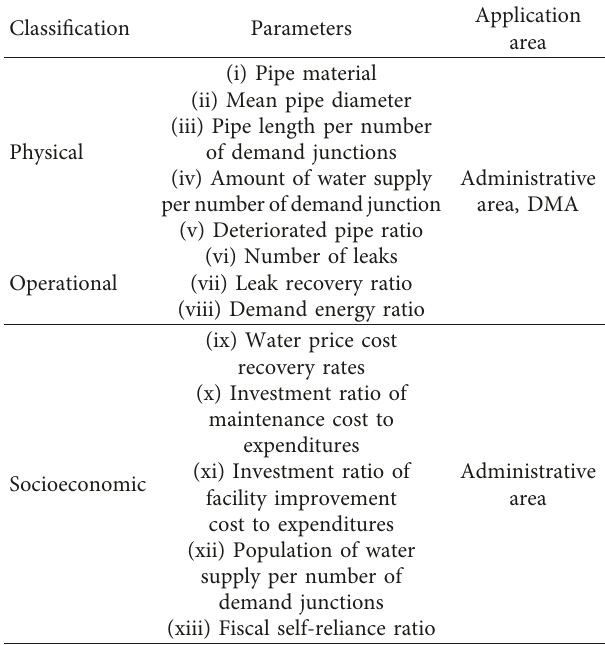
Table 6: Final selected parameters for NRW management [4, 8,